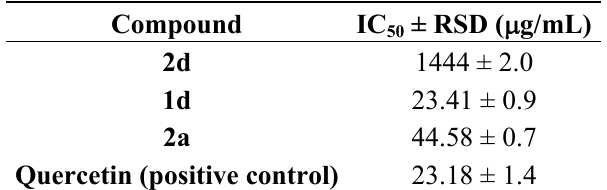
Table 3. Scavenging activity observed for 1d , 2a and 2d in the DPPH